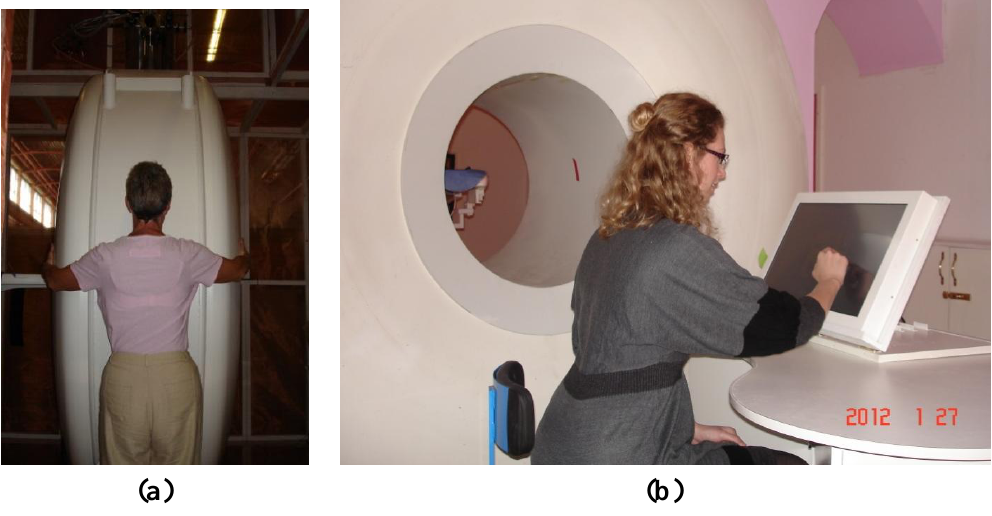
Figure 3. ( a ) A superconducting magnet based Intra-Operative Breast MR Scanner (Specialty Magnetics Limited, Middlesex, UK) currently operated at 0.5T for occupational health reasons with 70 cm bore-length and 70 cm bore-diameter. ( b ) MR Scanner features an MR-compatible, in-room, touchscreen Operator’s Terminal through which the Clinician(s) can control all the subsystems of the MR Scanner and perform interventional procedures under real-time MRI guidance. MR Scanner also features a highly maneuverable Patient Positioning System which, as well as traditional vertical and horizontal travel, can also rotate clockwise or counter clockwise to locate the breast precisely at iso-centre of the magnet.